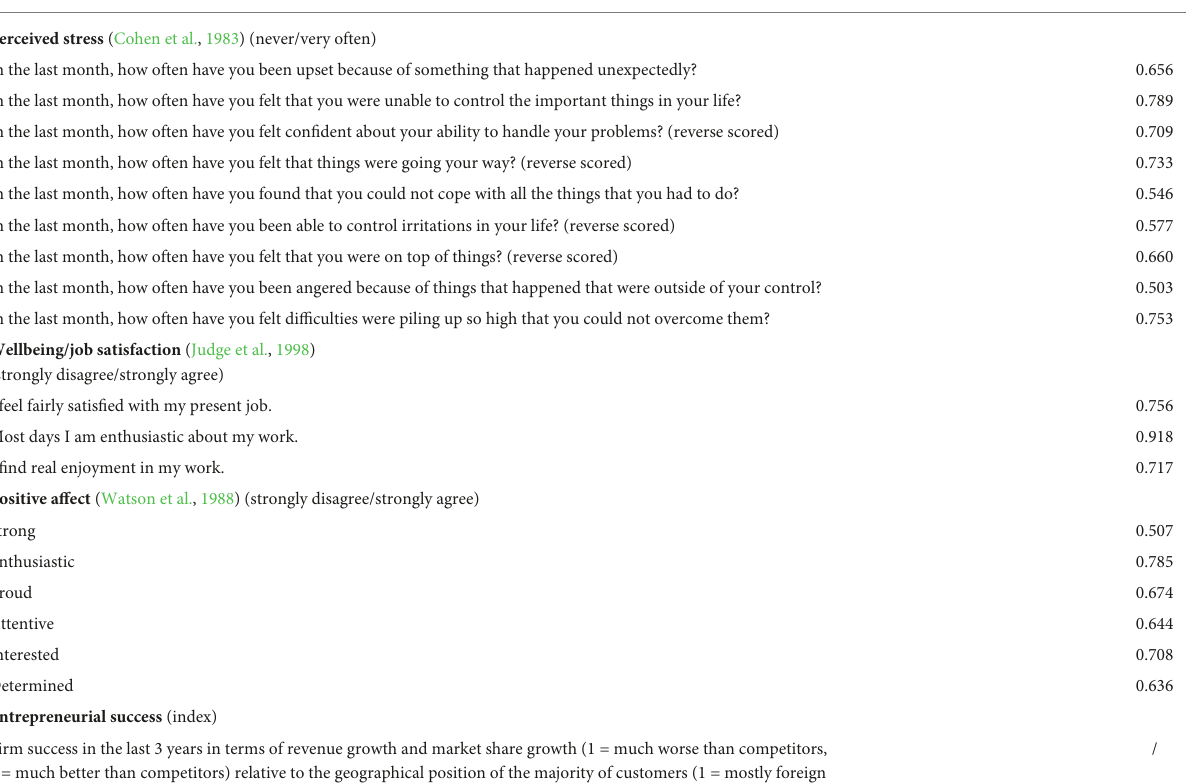
Table A1 Final scale items and standardized loadings based on the CFA.